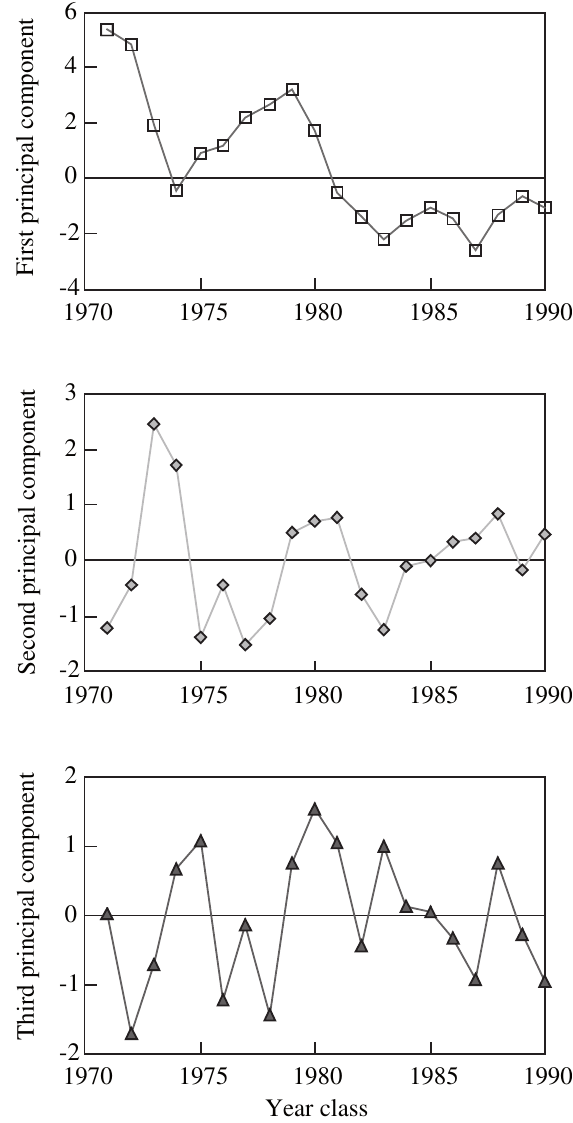
Fig . 3. – Plot of the first three principal components (PC) derived in the proposed principal component analysis of size data of age groups 1 to 6 for the 1971 to 1990 year